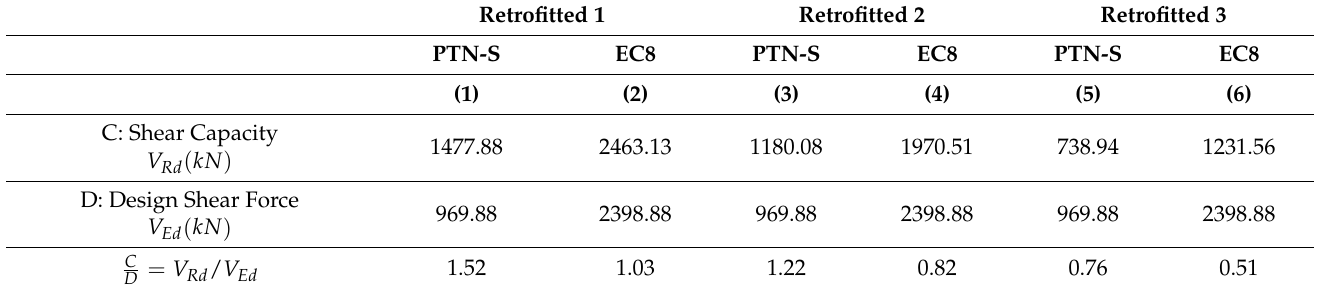
Table 5. Comparison of seismic capacity (C) and demand (D) at the ground floor level of the building in N–S direction (for the retrofitted structure).